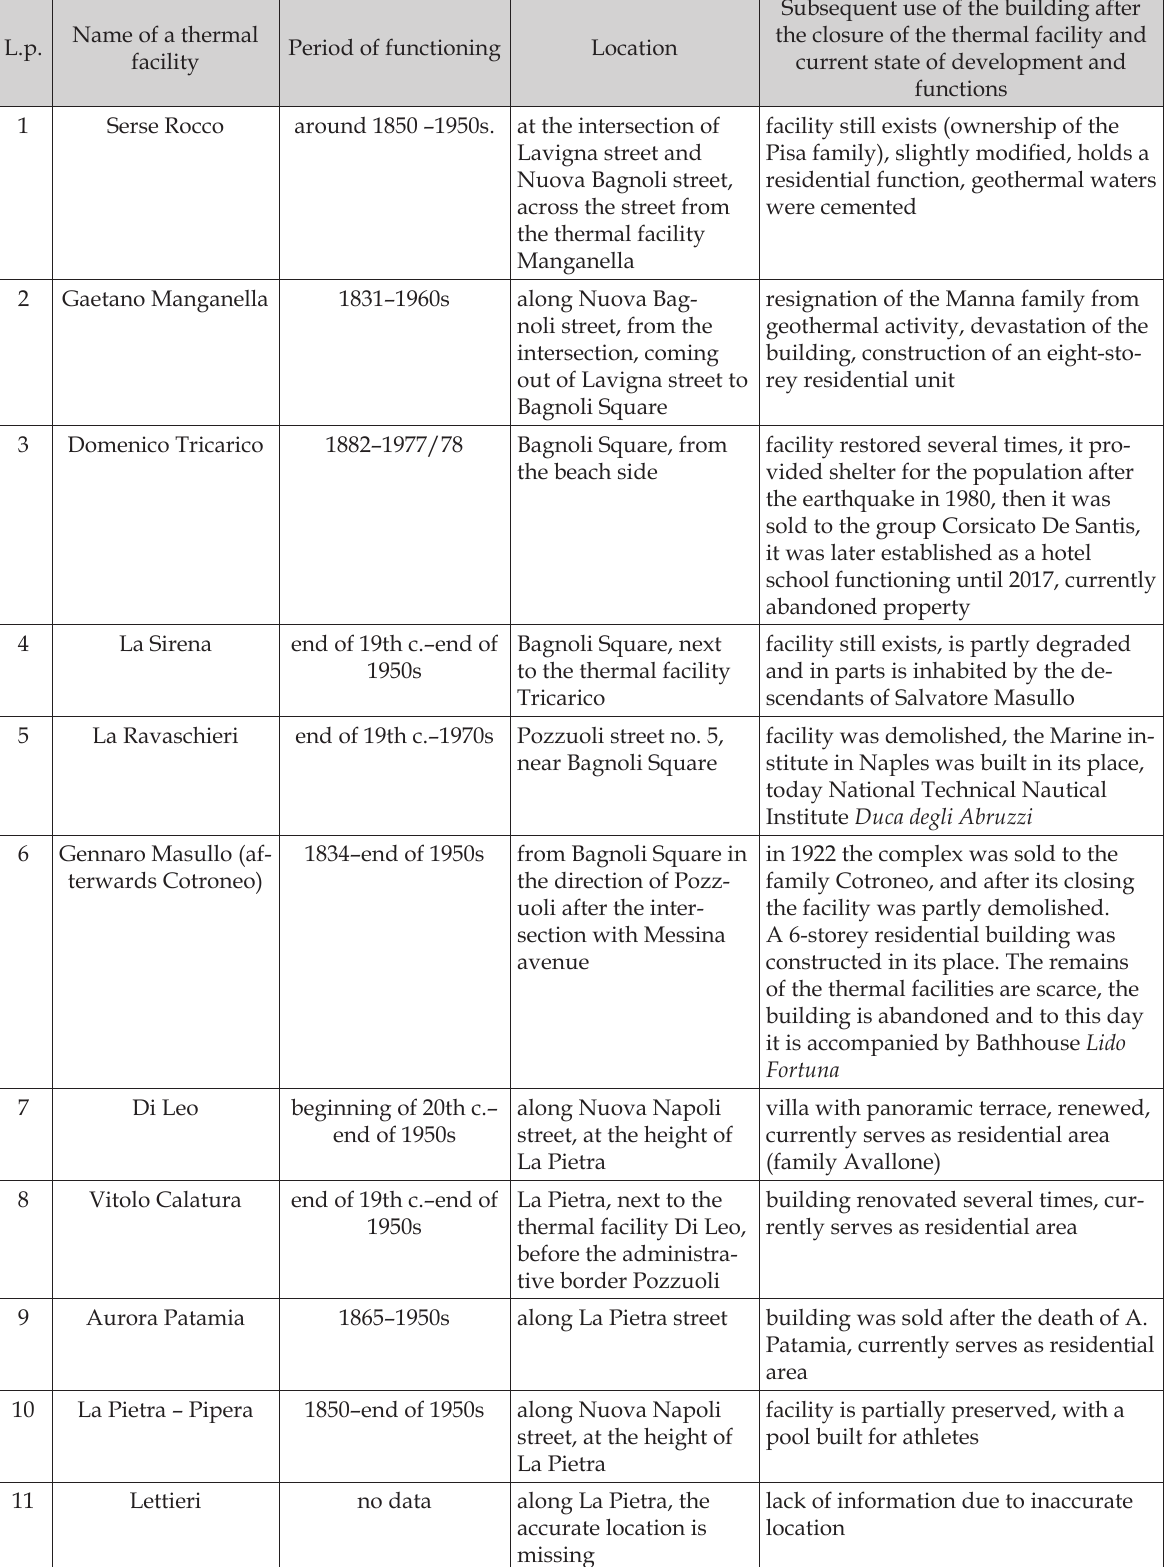
Table 1. Basic information about the thermal facilities in the districts of Bagnoli and La Pietra.